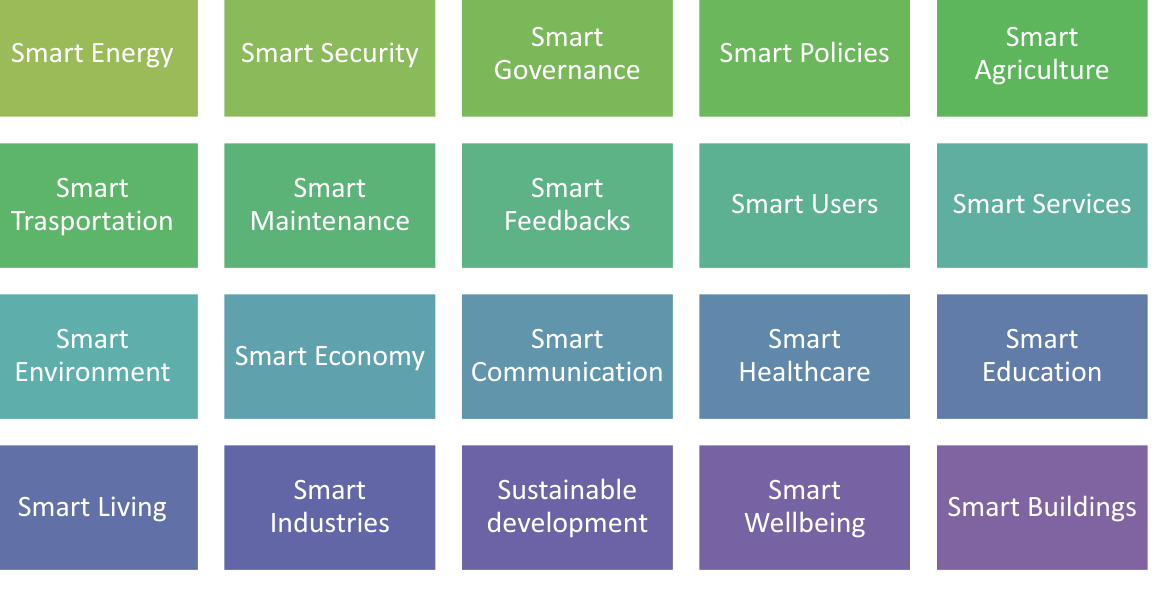
Figure 2. Smart city subsystems.